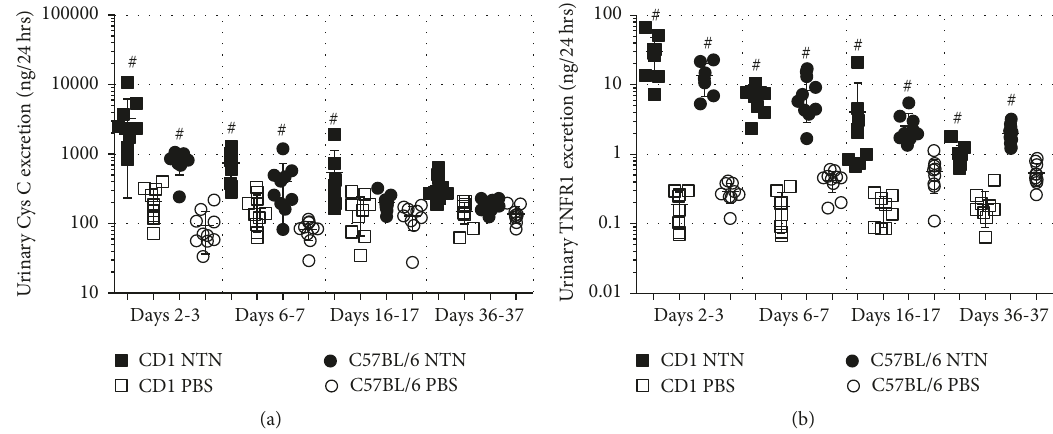
Figure 5: NTS induces significant urinary excretion of Cystatin C and TNFR1 . (a) Scatter plot showing the 24 h urinary Cystatin C excretion rate over time measured by ELISA. (b) Scatter plot showing 24 h urinary TNFR1 excretion rate over time measured by ELISA. Data are shown as mean ± SD. # 𝑃 < 0.01 NTN groups versus PBS groups by two-way ANOVA ( 𝑛 = 10 ).